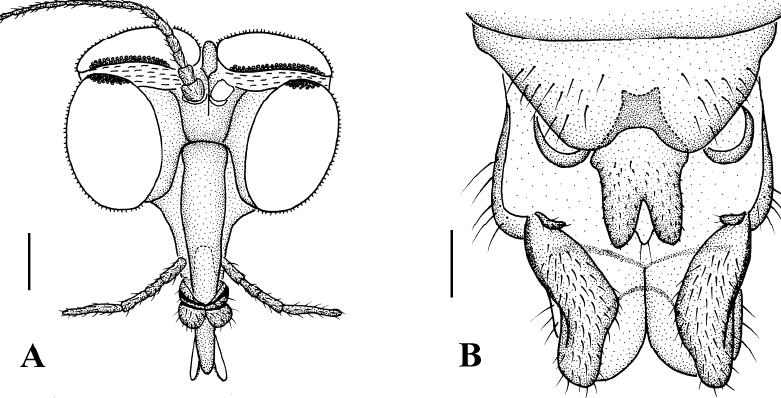
Figure 13. Blepharicera xinjiangica sp. nov. (female paratype). ( A ) female head, frontal view ( B ) female terminalia, ventral view. Scale bars: 0.25 mm ( A ), 0.10 mm ( B ). Distribution. Currently known only from China (Xinjiang).